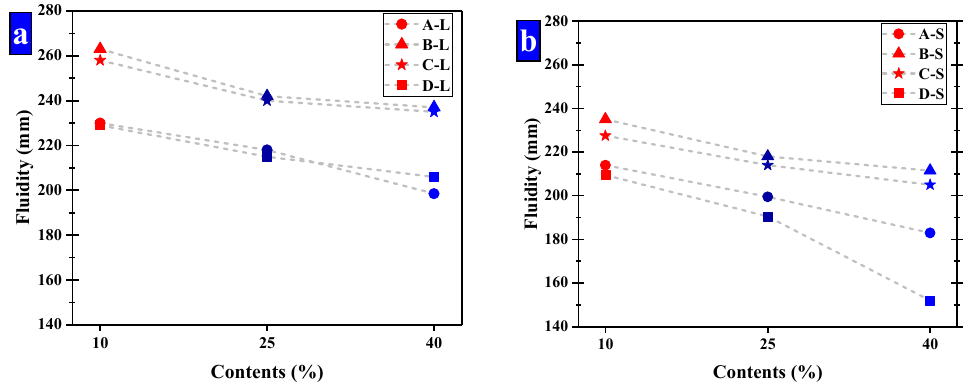
Figure 12. The fluidity of mortar that have been compound allocation. ( a ) Large-sized pellets; ( b ) small-sized pellets.